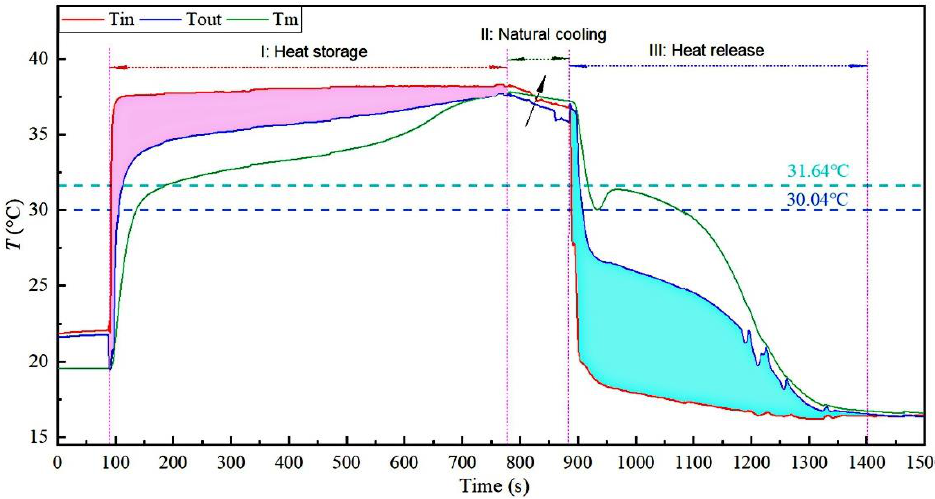
Figure 12. Temperature distribution of water and PCM (10 wt.% EG).